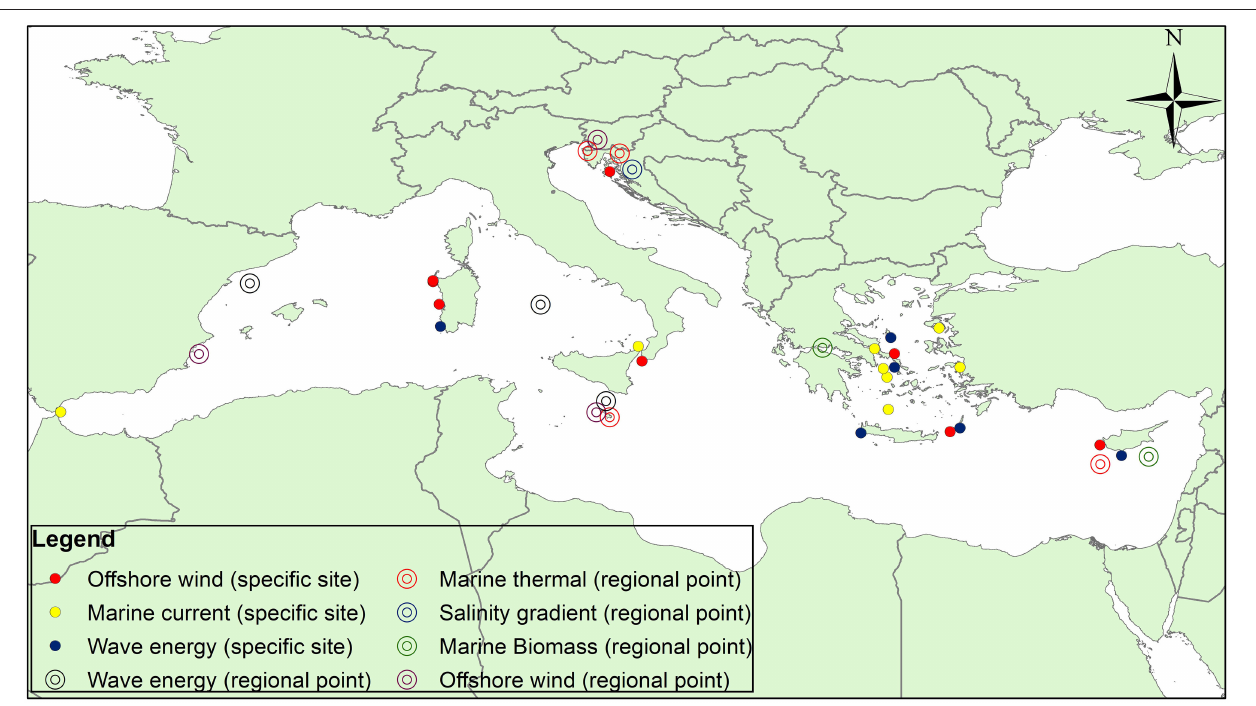
FIGURE 2 | Locations of highlighted BE forms as reported from the partners. Solid circles represent specific locations, while hollow circles represent general regions.